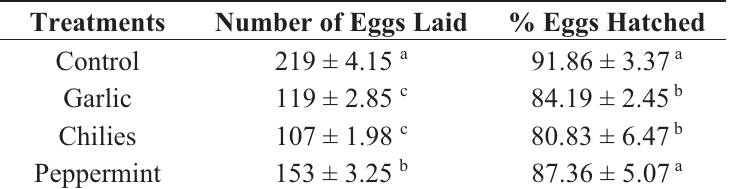
Table1. Effects of natural plant products on the number of eggs laid by the cowpea weevil and percentage of eggs